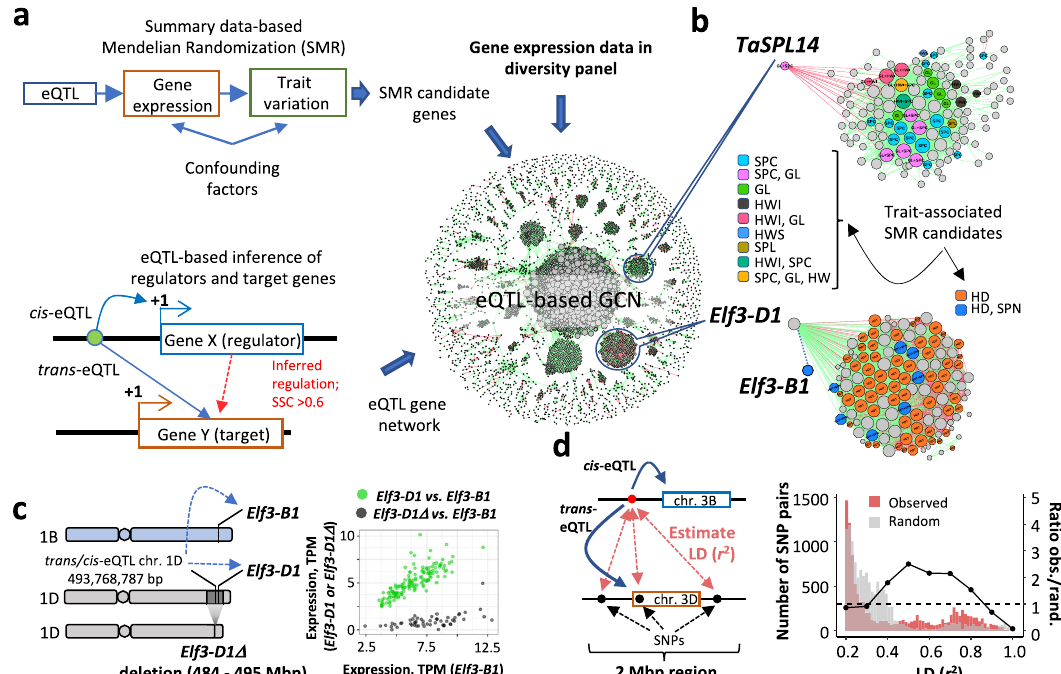
Fig. 5 Joint eQTL and GWAS analysis of agronomic traits in wheat. a Outline of the strategy used to integrate eQTL and GWAS data to investigate the genetic basis of yield component and development trait variation in wheat (see “ Methods ” ). We used fi eld-based phenotyping data collected for a diverse panel of ~800 wheat accessions from the 1000 wheat exomes project 8 including grain fi lling period (GFP), harvest weight (HW), drought susceptibility index for harvest weight (HWS), heading date (HD) and plant height (PHT) traits. A set of phenotypic traits was collected for a diverse panel of 400 wheat accessions: grain length (GL), grain width (GW), thousand-grain weight (TGW), grain area (GRA), spike compactness (SPC), spikelet number per spike (SPN), awnedness (AWN), and height (PHT) (Supplementary Data 10). b Gene co-expression network (GCN) modules, including TaSPL14 and Elf3 genes, are enriched for genes associated with agronomic traits in SMR analyses. c eQTL located on chr. 1D acts as a cis -variant for Elf3-D1:TraesCS1D01G451200 (GWAS FDR-corrected p -value = 4e − 54) and is tightly linked ( r 2 > 0.8) with variants acting as trans -variants for Elf3-B1:TraesCS1B01G477400 (GWAS FDR-corrected p -value = 9e − 10). A deletion of Elf3-D1 ( Elf3-D1 Δ locus) in wheat affects both HD and SPN traits. d . Distribution of LD between negatively correlated homoeologs compared to LD between the random set of homoeolog pairs. LD was measured between the cis/trans -eQTL in one homoeologue and SNPs within a 2-Mb window, including another homoeologue. Only LD values above r 2 > 0.2 we r e plotted. The right y -axis shows the ratio of SNP pairs within different LD ranges (the dotted line shows a ratio of 1.0) estimated for the negatively correlated and random pairs of homoeologs. Source data are provided as a Source Data fi